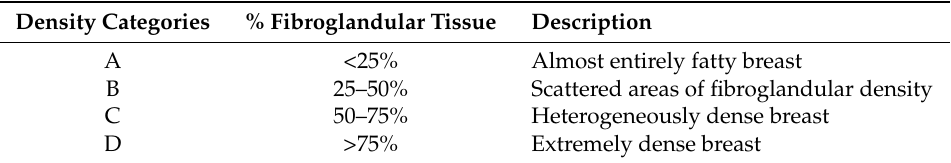
Table 1. BI-RADS ® breast density description [43].